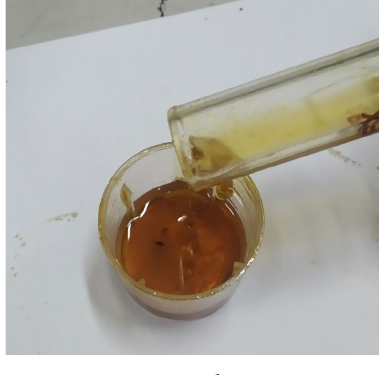
Figure 4. Rediset